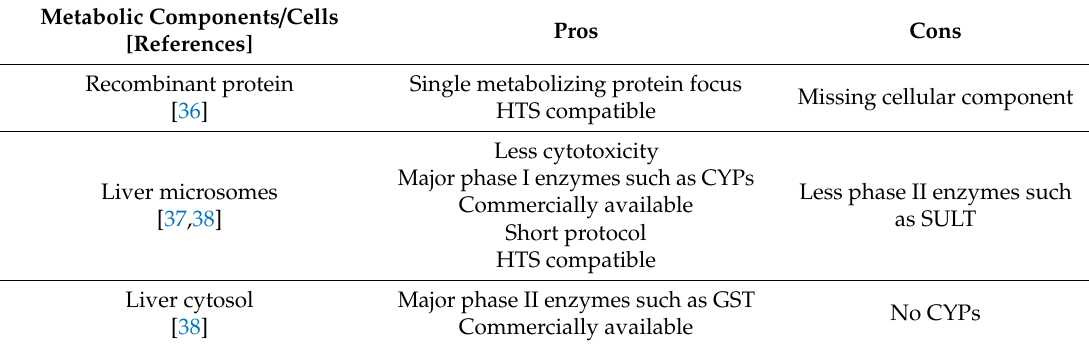
Table 1. Comparison of metabolic components from protein to